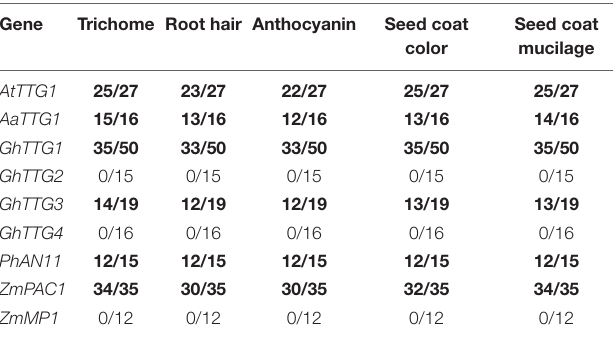
TABLE 1 | T1 plants or T2 lines transformed with pAMPAT-35S-WDR showing phenotypic rescue (rescued lines/total number of lines) in